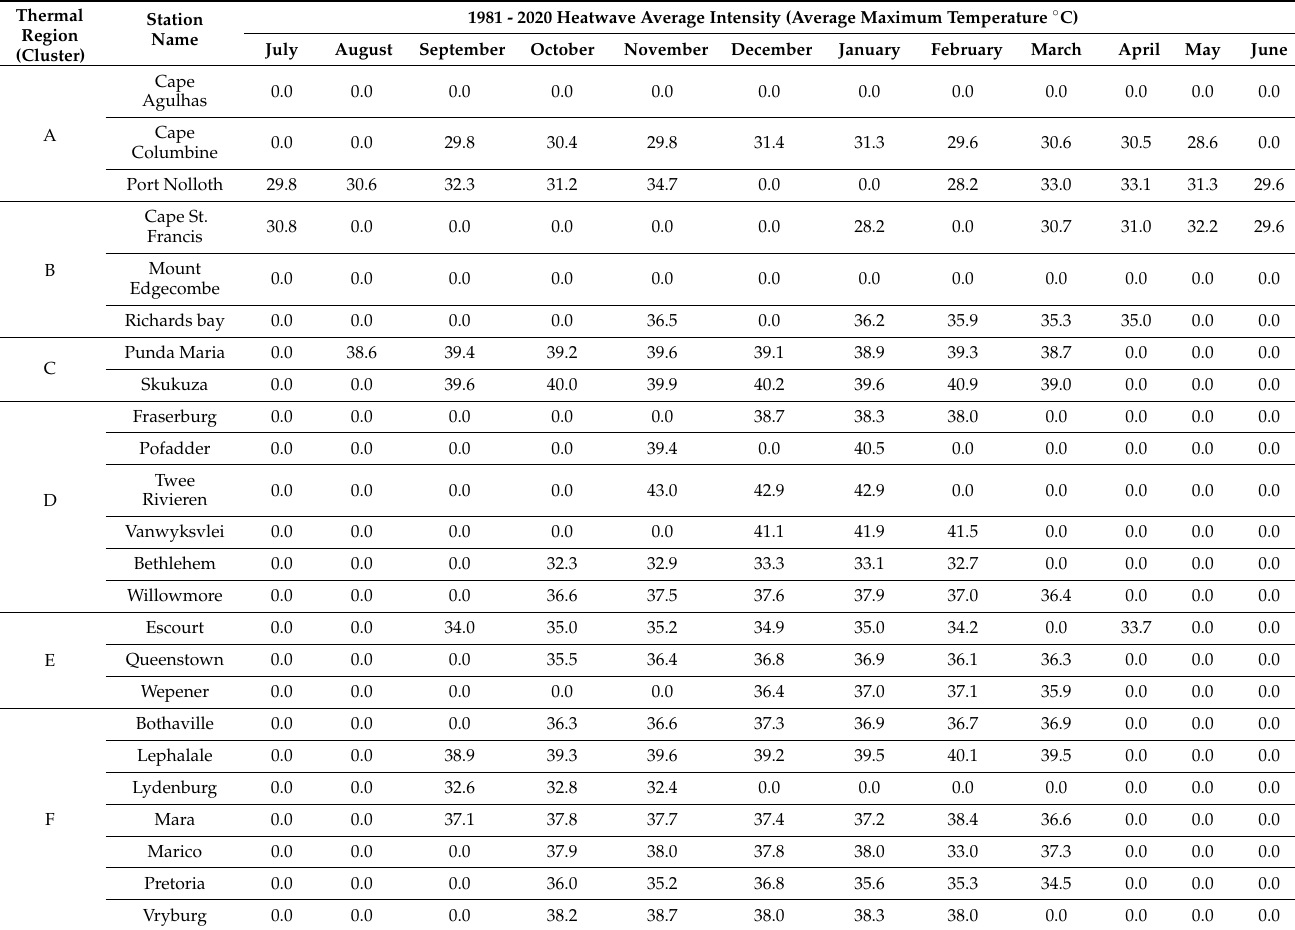
Table 5. The monthly HW average intensity from 1981–2020 from the 24 selected